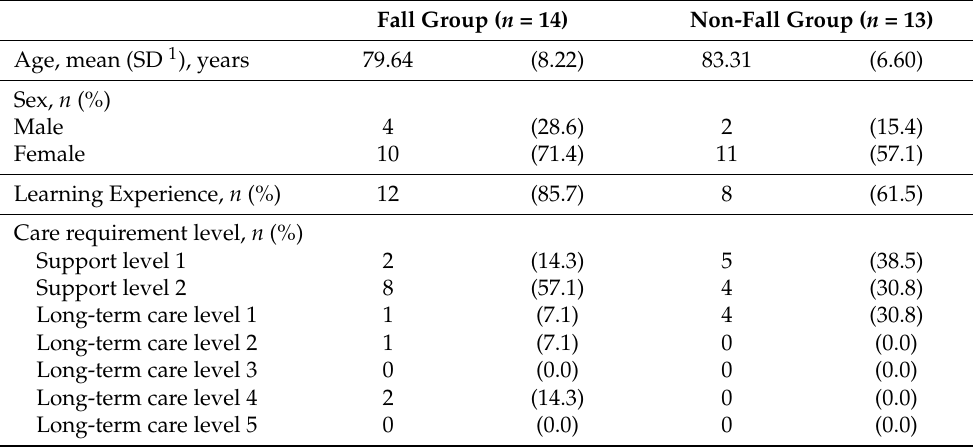
Table 1. Comparison of characteristics of the fall and non-fall groups. Fall Group ( n =